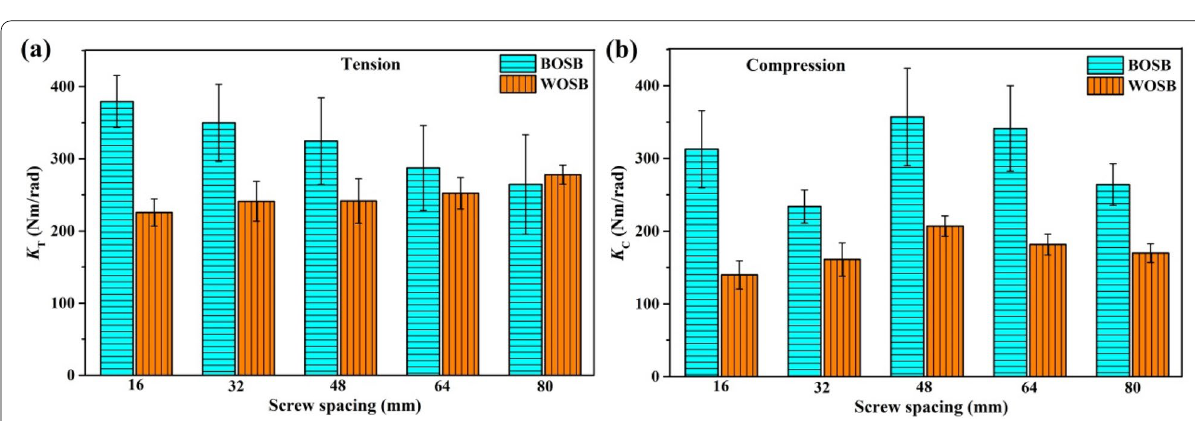
Fig. 9 Stiffness coefficient for joints subjected to: a tension, b